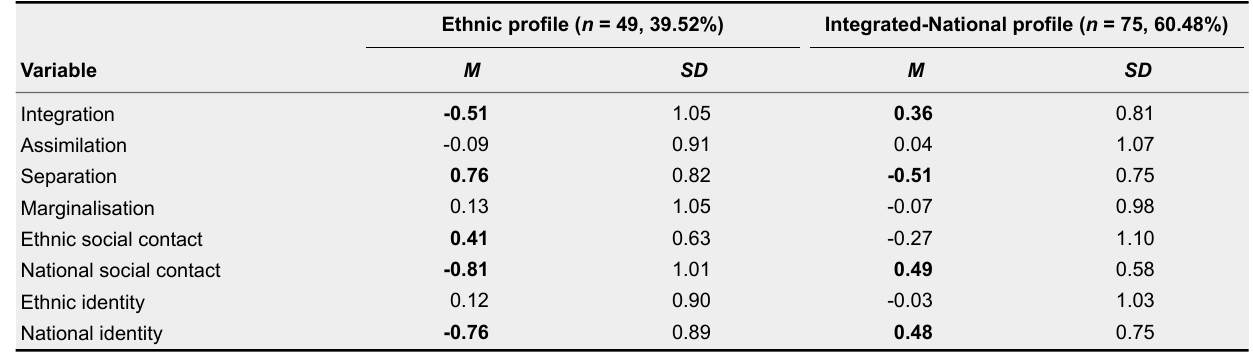
Means and Standard Deviations of Tunisian Acculturation Variables (Z-Scores) by Configuration (n = 124)